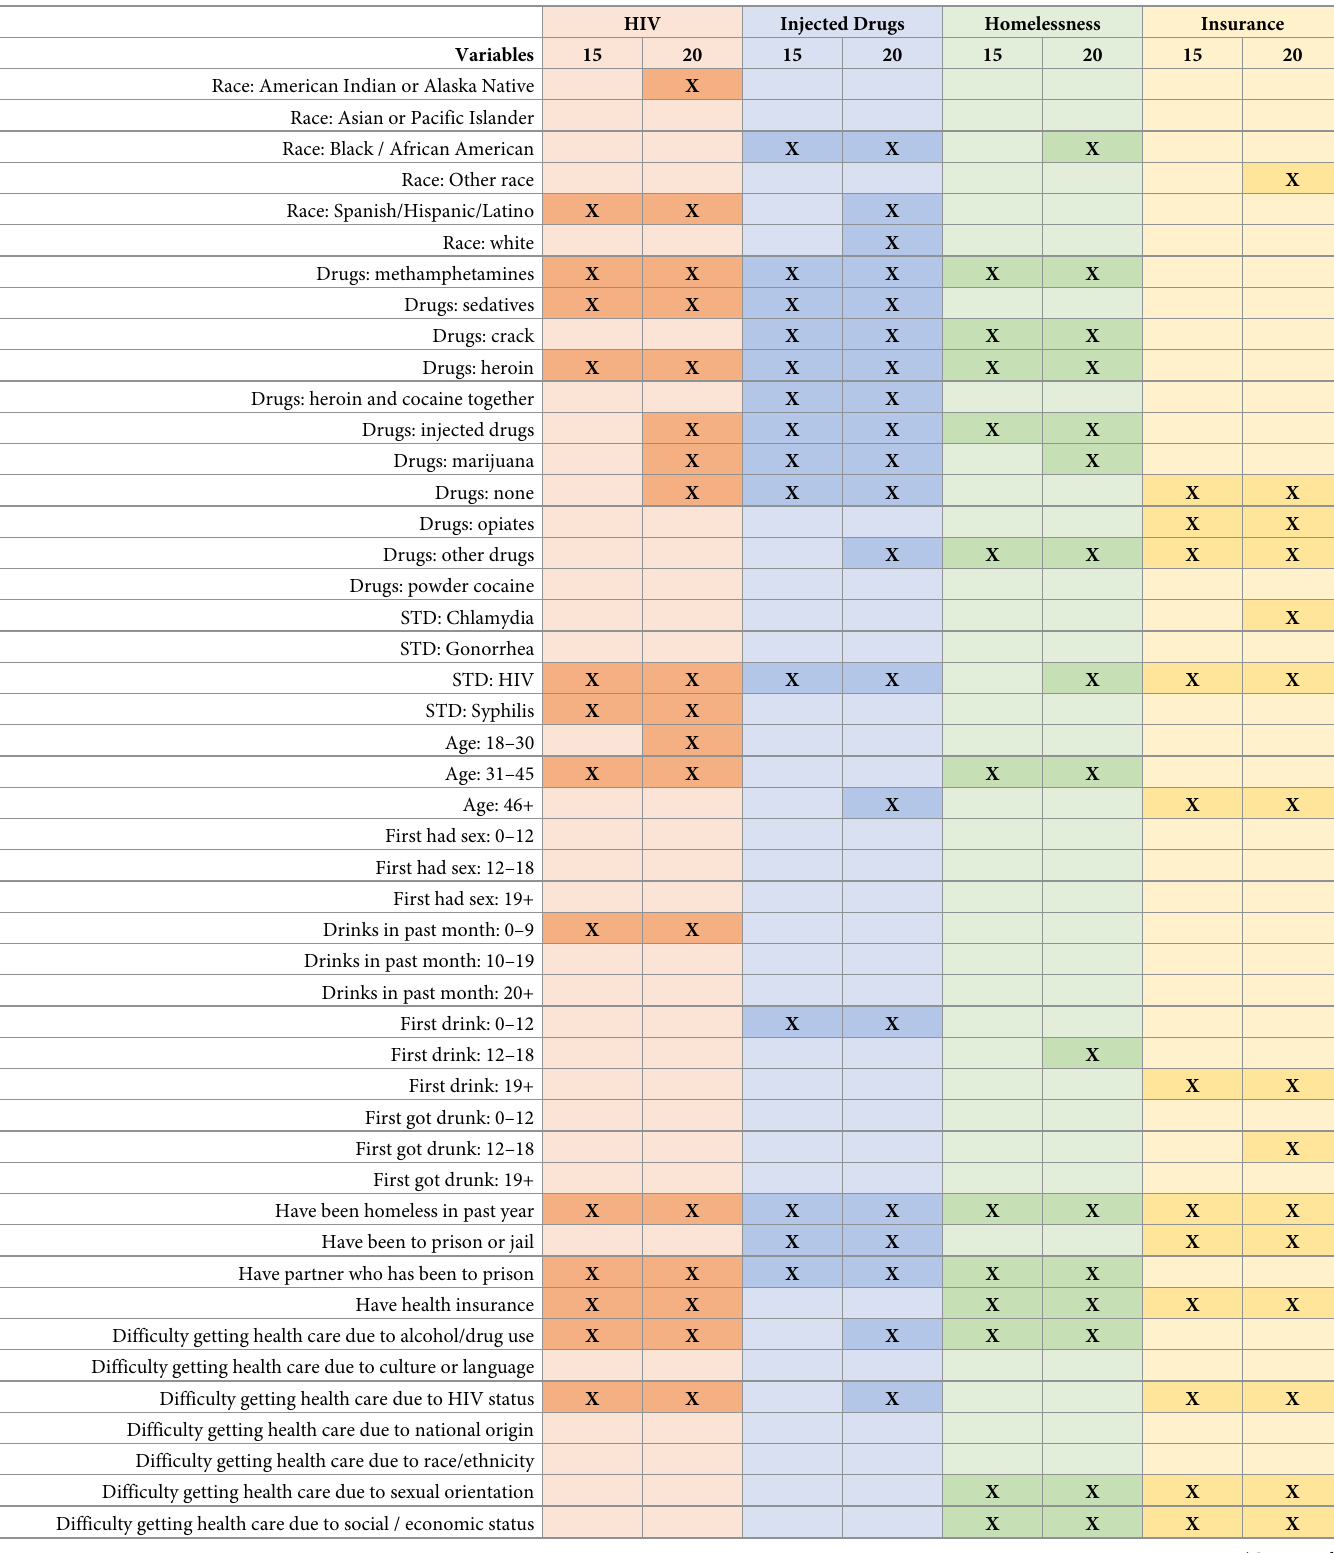
Table 1. A list of all 64 variables used in the features selection along with the best features of size 15 and 20 for each of the four target